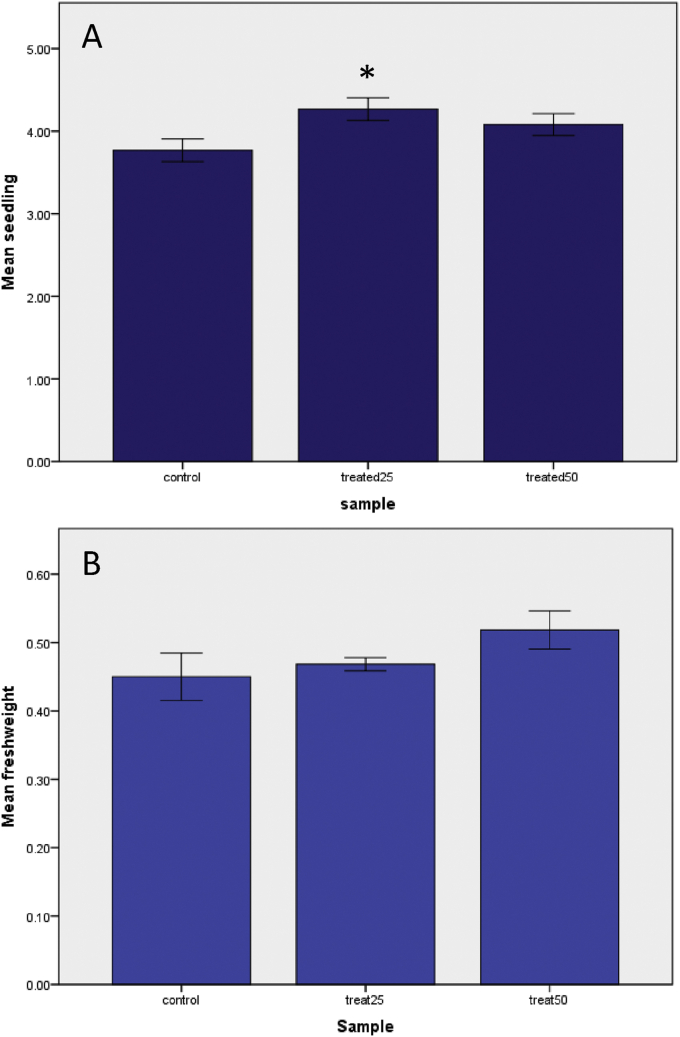
Effect of two different concentrations of ZnO NPs (25 ppm and 50 ppm) on both lettuce seedling length (A) and fresh weight of lettuce seedling (B). Values are the means for each criterion and the vertical bars represent standard errors. Significant difference (p < 0.05) are marked with “∗”.